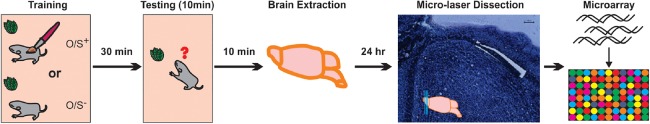
Timeline for peppermint odor or odor + stroking training, odor preference testing and LMD followed by microarray analysis. The thionin-stained section shows a region of the mitral cell layer (MCL) (excised) that was microdissected prior to sample collection in an assay tube. The bar indicates 100 microns. The lasered region is in a dorsolateral quadrant of the MCL normally activated by peppermint.